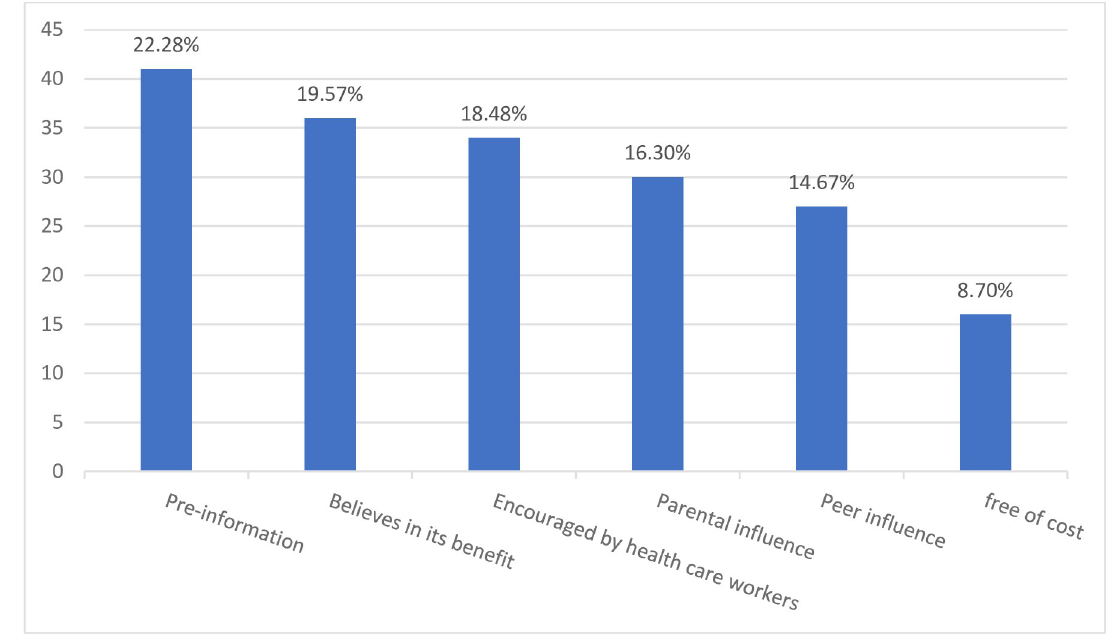
Fig 2. Reasons for considering to get vaccinated among adolescent school girls in Ambo town, central Ethiopia, 2020 (n = 184).